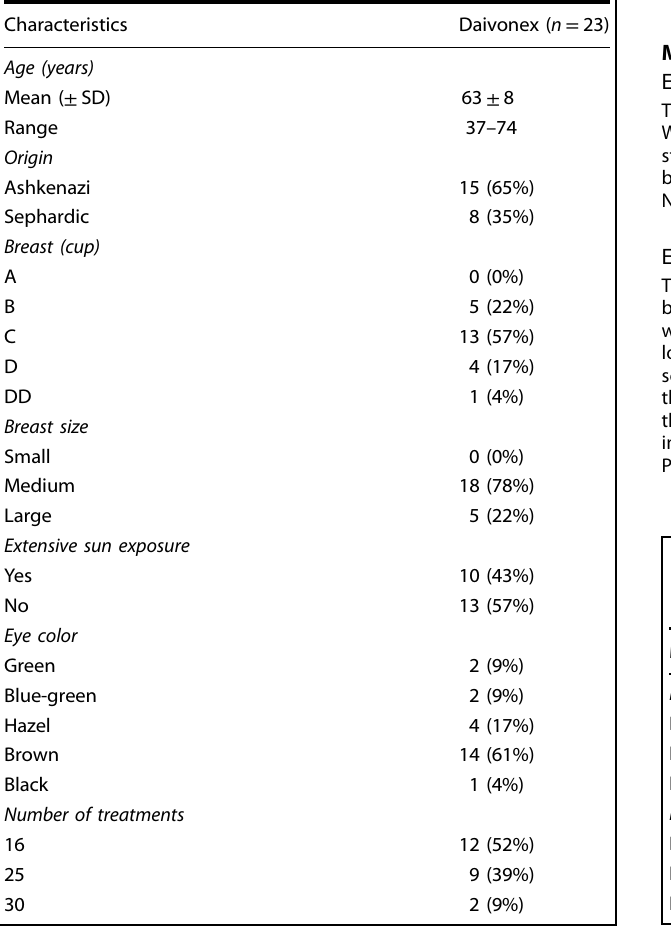
Table 2. Breast skin toxicity according to RTOG scale in the parts of the breast treated with Daivonex or Aqua cream Toxicity grade Clinical Reaction